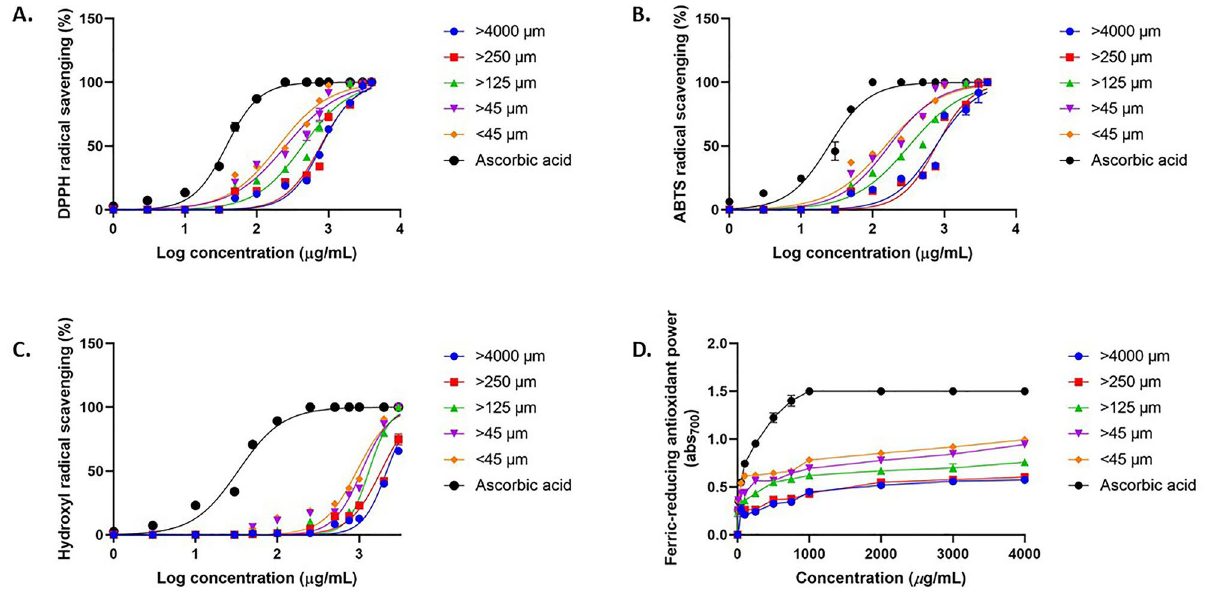
Figure 4. Effect of particle size on S.cristaefolium extract antioxidant activity based on ( A ) DPPH, ( B ) ABTS, ( C ) hydroxyl, and ( D ) ferric reducing assay. Experiments are done in triplicates, values are expressed as means ± SEM.